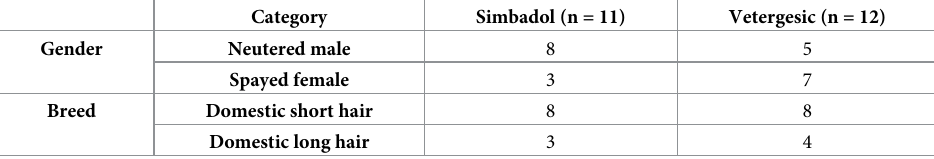
Table 1. Demographic data including gender, reproductive status and breed of cats undergoing dental extractions and treated with Simbadol or